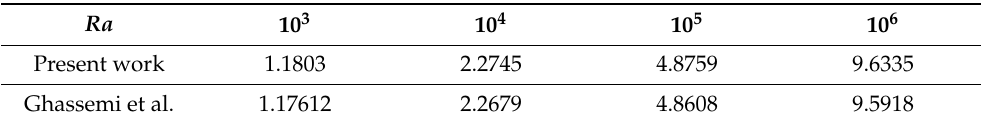
Figure 3. ( left ) Numerical results from Calcagni et al. [35]; ( right ) The present study for streamlines at Rayleigh number (Ra) = 10 6 . Table 3. Validation of the present code, for the Nu avg with Ra at Hartmann number (Ha) = 0, with a cavity by Ghassemi et al. [30].